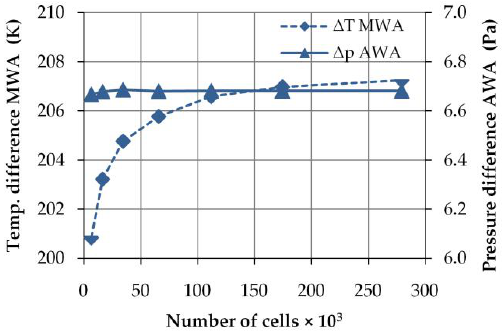
Figure 6. Meshindependence test for a porous media model of a nine-layer reactor with 3-mm Figure 6. Mesh independence test for a porous media model of a nine-layer reactor with 3-mm spheres (the chosen mesh contains 175  10 3 cells). spheres (the chosen mesh contains 175 × 10 3